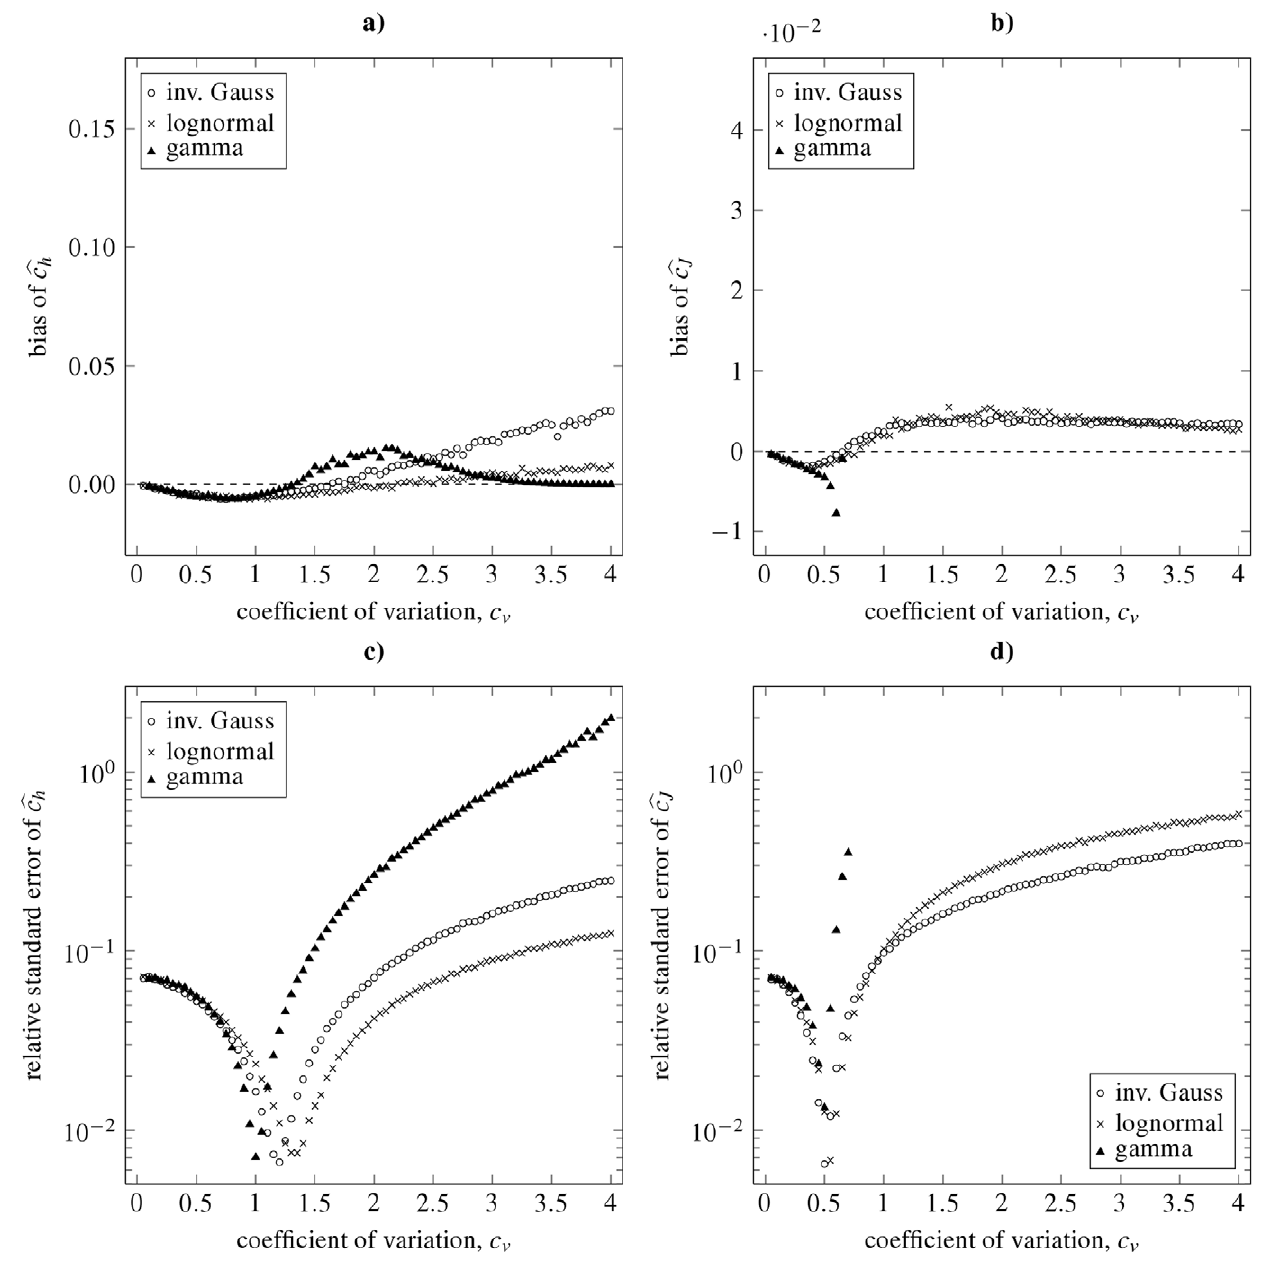
Figure 7. Dispersion coefficients estimation by using the maximum likelihood method from simulated data. Bias (panels a , b ) and relative standard deviations (panels c , d ) of the dispersion coefficients estimates b c h c h (panels a , c ) and b c J c J (panels b , d ), in dependence on the true value of the coefficient of variation, c v , are shown. The depicted characteristics were estimated from simulated random samples drawn from inverse Gaussian (circles), lognormal (crosses) and gamma distribution (triangles). Coefficient b c J c J for gamma distribution (panels b , d ) can be computed for c v v 0 : 707 only.